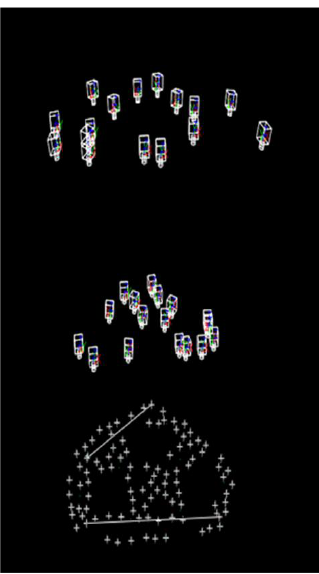
Figure 4. A combined bundle block adjustment was calculated to retrieve coordinates for the reference points as well as image orientation and camera geometry for two camera settings.